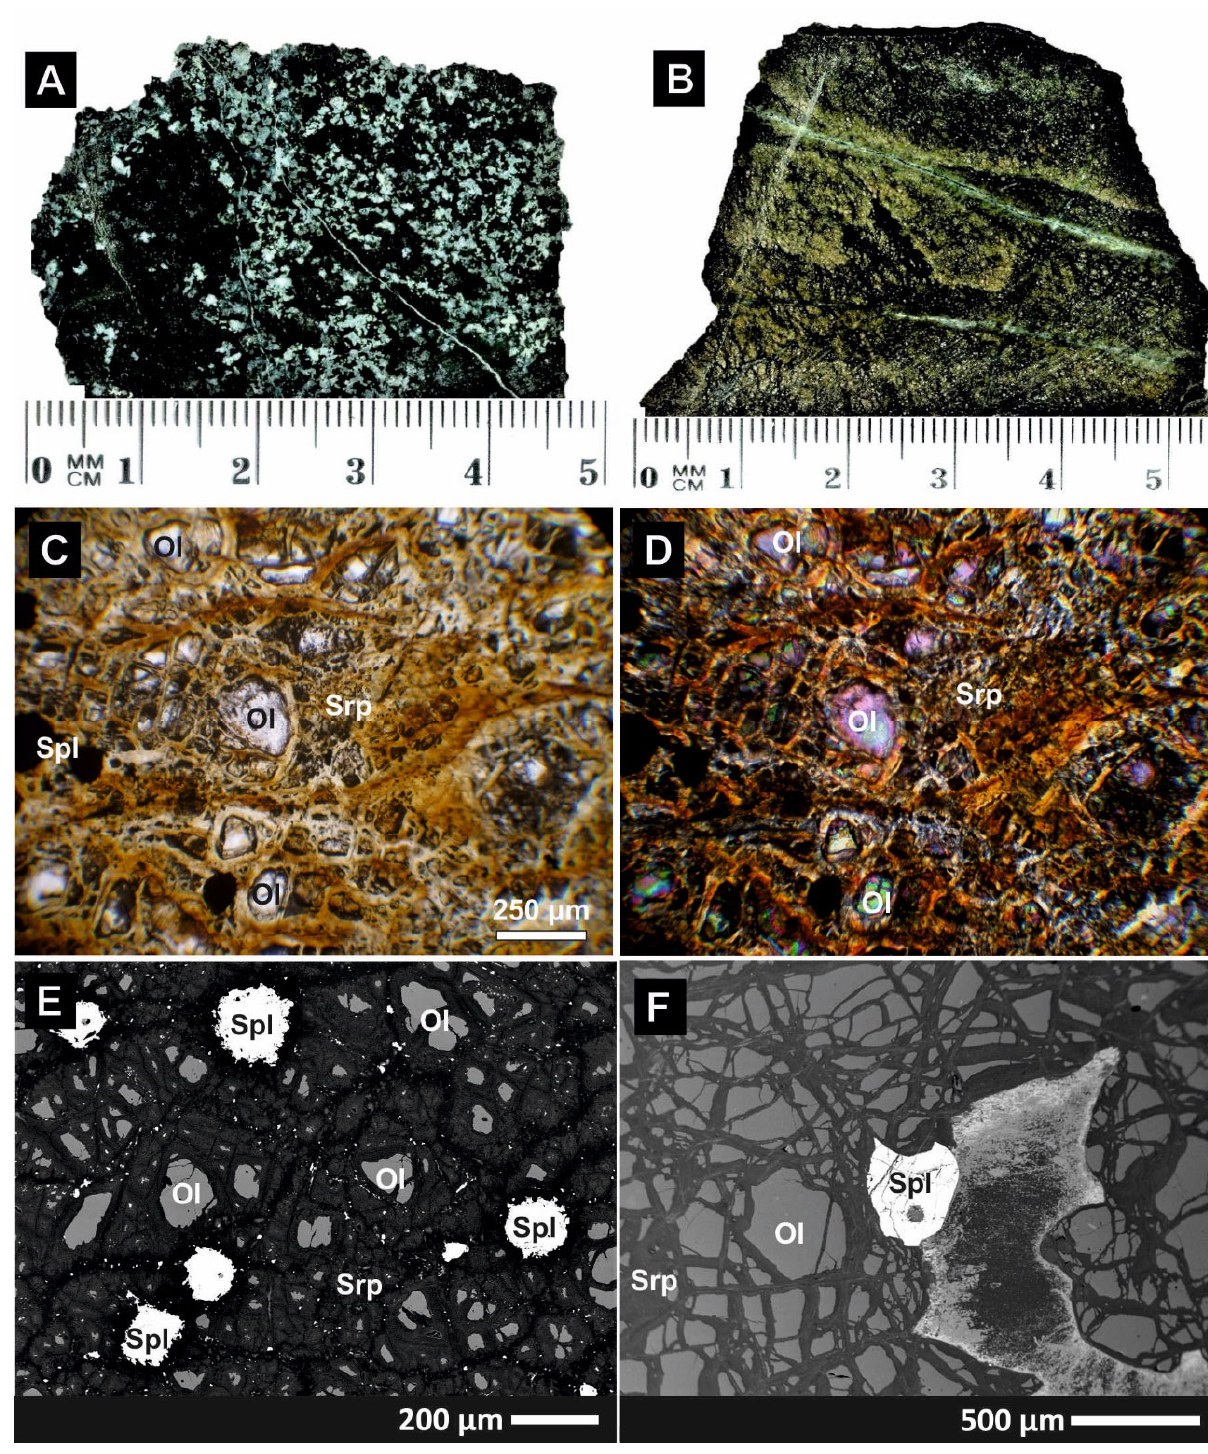
Figure 8. Macroscopic (A,B), PL microscopic (C,D), and BSE (E,F) images of dunite samples: ( A ) Feldspatitization of dunite to troctolite P19A2 at the contact with Cpx–Pl gabbro dyke P19A1. ( B–E ) Dunite P11A. ( F ) Dunite P18D. Picture C at II P; D at X P.